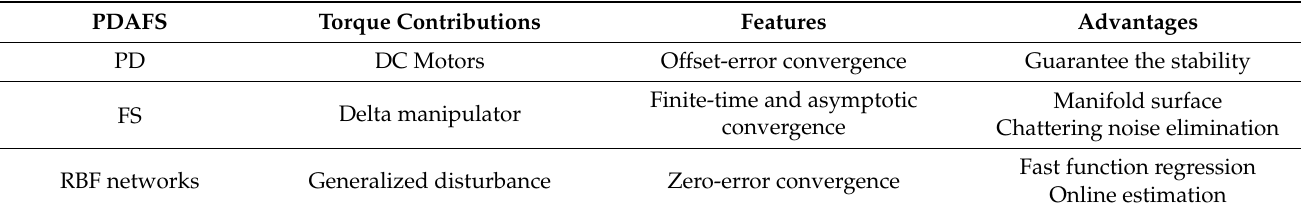
Table 3. The contribution and advantages of object-oriented model control in